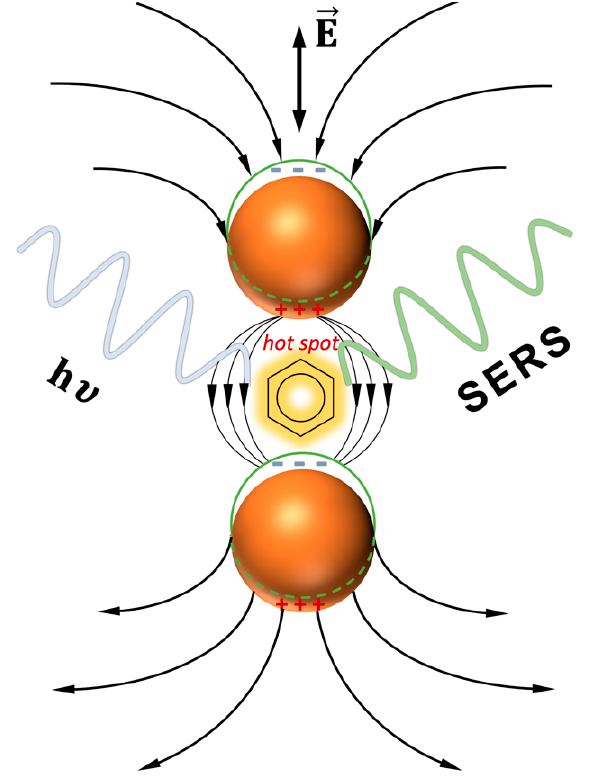
Figure 1. Scheme of the surface-enhanced Raman scattering (SERS) resulting from the electromagnetic effect. Image not to scale.